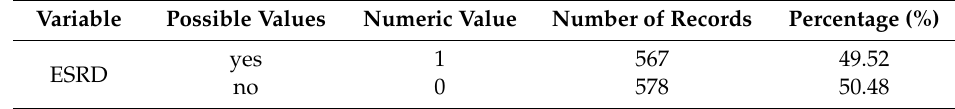
Table 3. Categorical dependent variable.